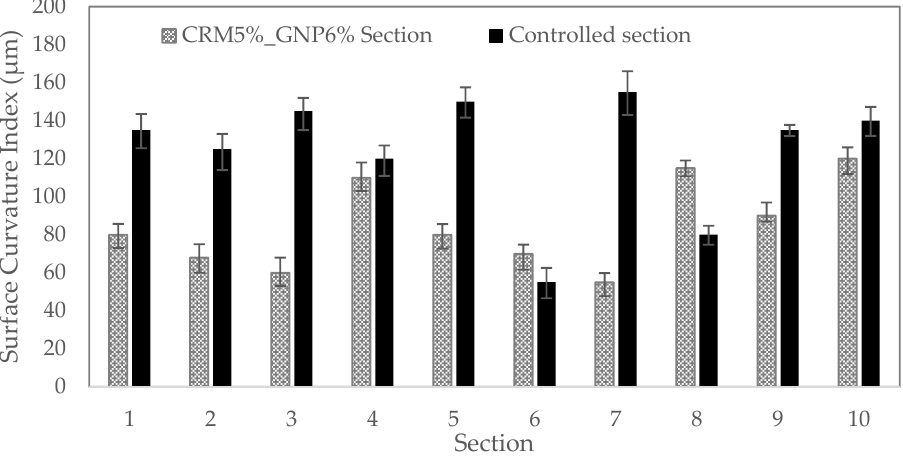
Figure 18. Layer index analysis (SCI).